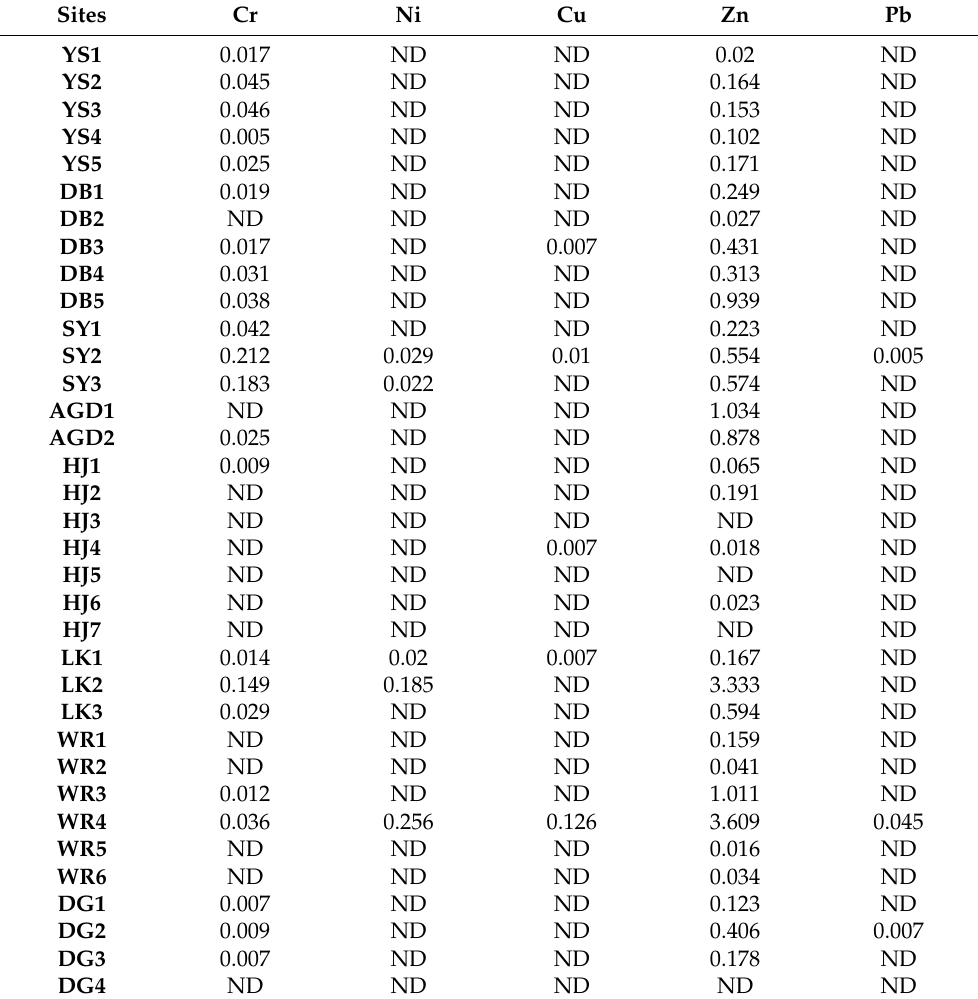
Table 5. Concentrations of heavy metals in sediment